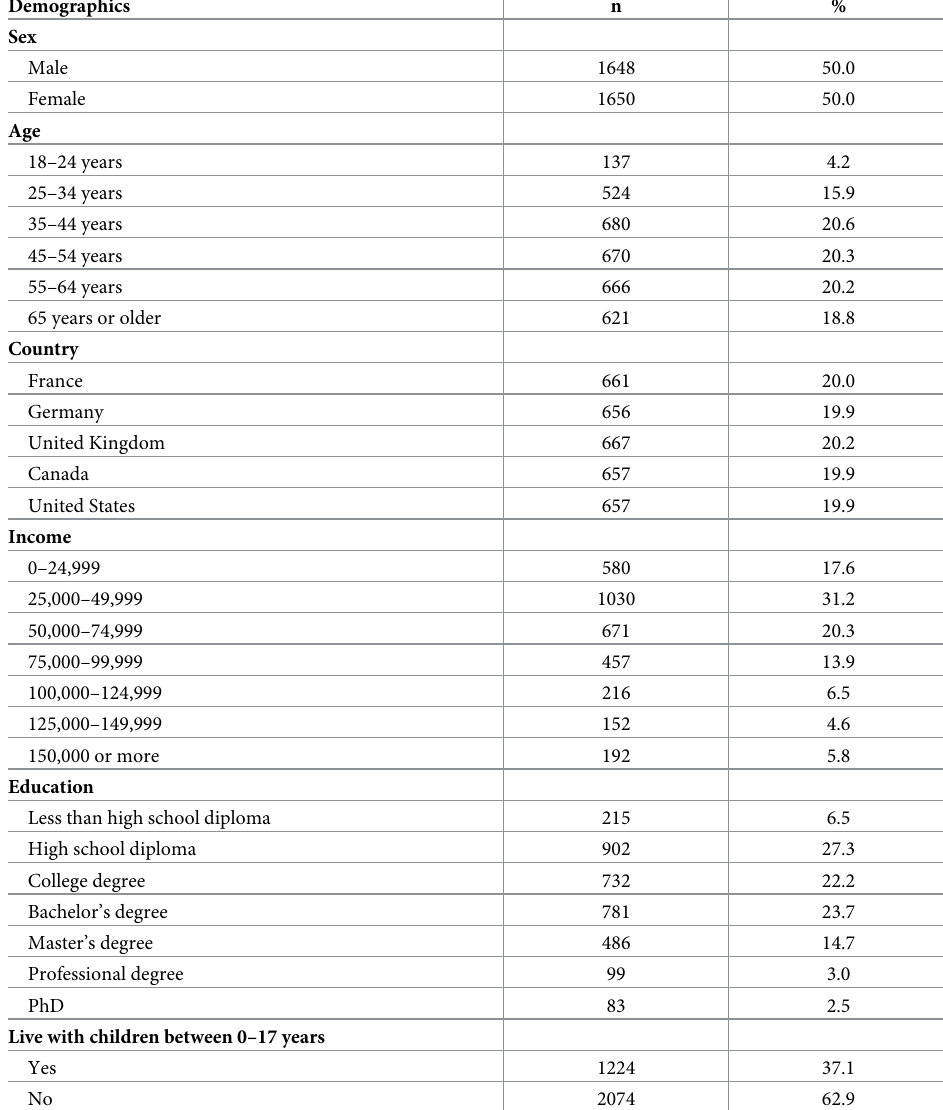
Table 1. Demographic data, including sex, age, country of residence, income, education and children living in the household from all respondents (n = 3, 298). Demographics n %